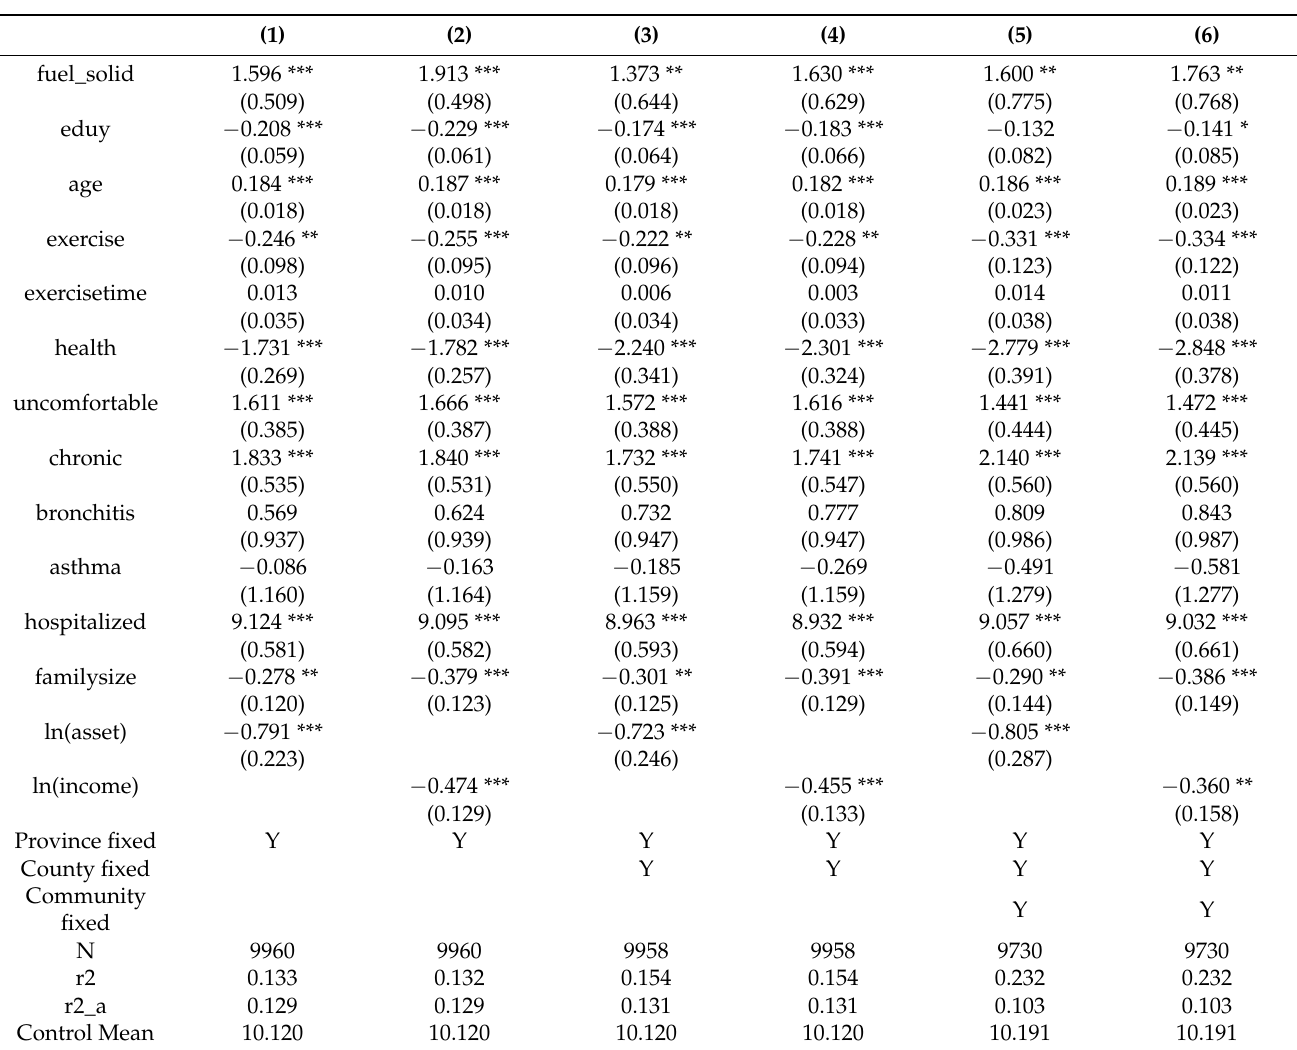
Table 2. Baseline regression results of solid cooking fuels on medical expense